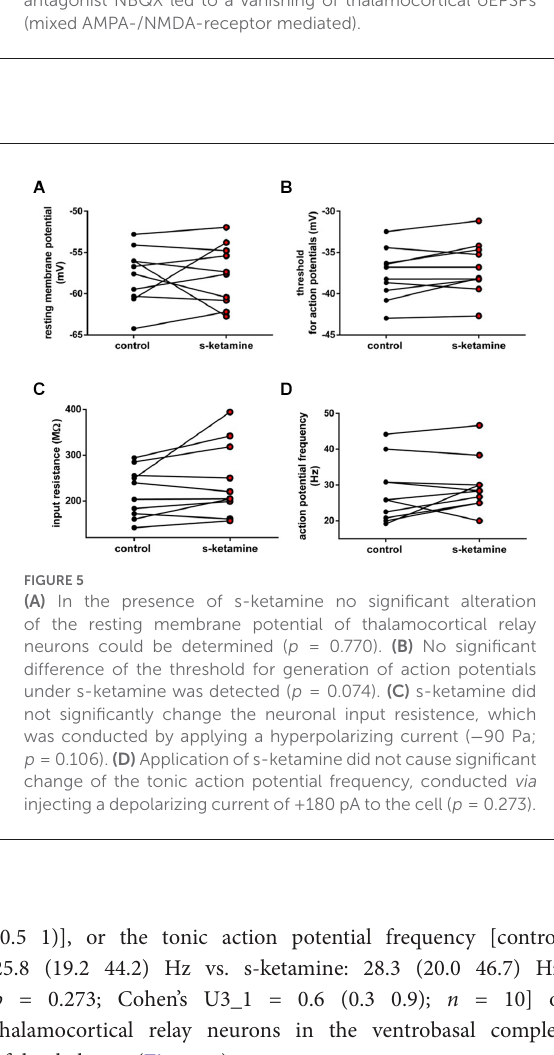
(0.5 1)], or the tonic action potential frequency [control: 25.8 (19.2 44.2) Hz vs. s-ketamine: 28.3 (20.0 46.7) Hz; p = 0.273; Cohen’s U3_1 = 0.6 (0.3 0.9); n = 10] of thalamocortical relay neurons in the ventrobasal complex of the thalamus ( Figure 5